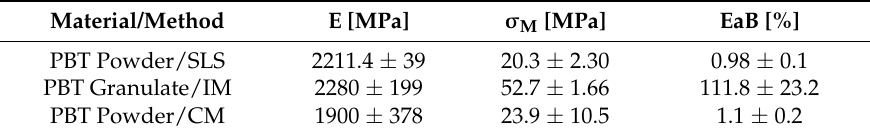
Table 6. Tensile results for PBT tensile bars.